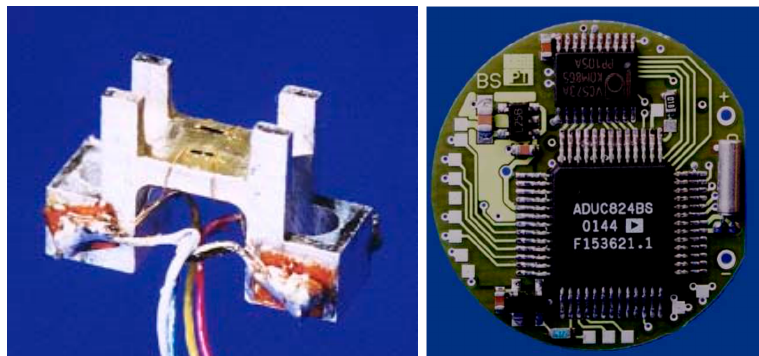
Figure 3. “Naked” implantable sensor device (6 mm × 3 mm × 1 mm) ( left ) and implantable data logger (Diameter 25 mm) ( right ).